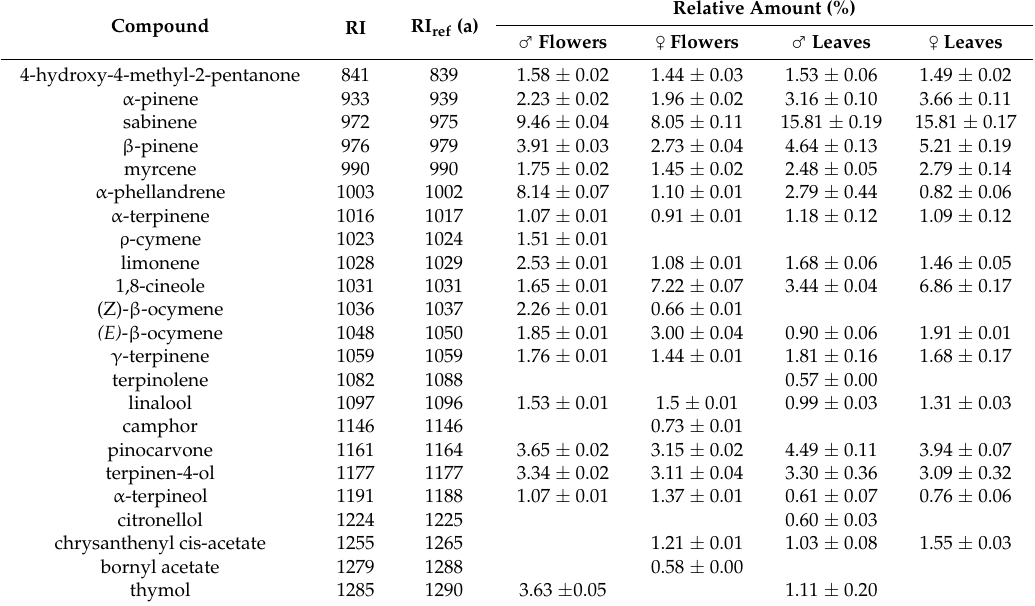
Table 1. Chemical composition of Hedyosmum brasiliense essential